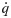
Replicator dynamics.Three-dimensional plot of the dynamic of the antibiotic prescribing game determined by the replicator equation. The ϕ axis represents the probability that a symptomatic patient has a bacterial infection, and the q axis represents the proportion of symptomatic patients in the population receiving antibacterial medication. The vertical axis is the value of q˙ = dq/dt.